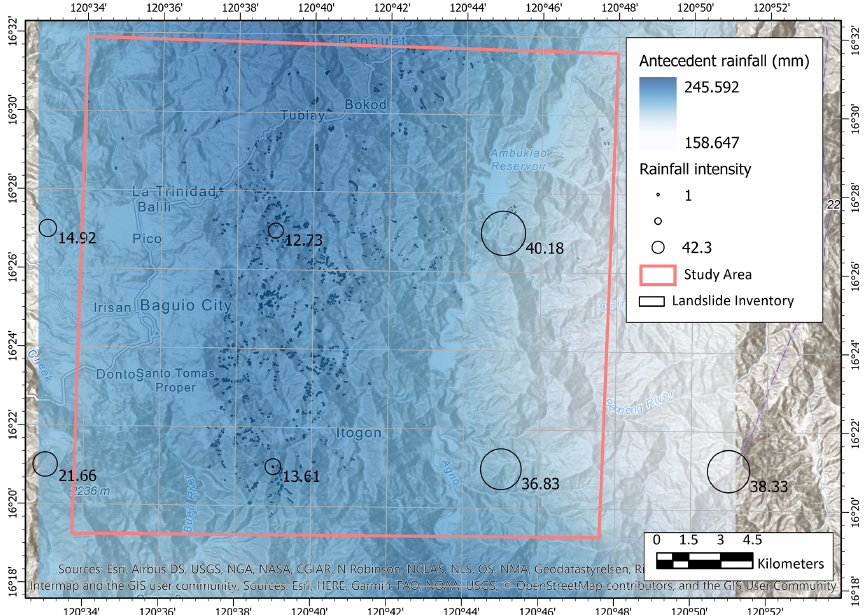
Figure 6. Colour gradient represents the antecedent rainfall, accumulated during the 13d before the typhoon. The values in the GPM IMERG grid points indicate the rainfall intensity on 15 September 2018 at 03:30UTC (maximum intensity in the study area). © OpenStreetMap contributors 2021. Distributed under a Creative Commons BY-SA License.